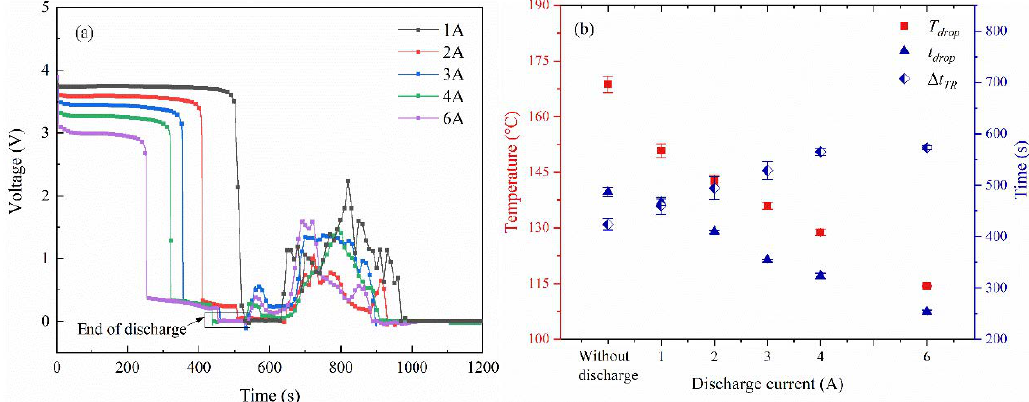
Figure 6. The voltage characteristics of the battery across thermal runaway when discharged with same C 0 (Group ⅱ ). ( a ) The voltage variation. ( b ) Average values of T drop , t drop , and ∆ t TR .